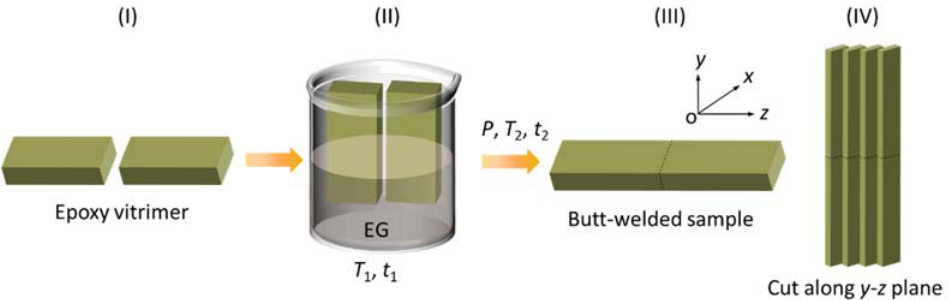
Figure 2. Schematic of the solvent-assisted welding process of epoxy vitrimer: ( I ) original epoxy vitrimer, ( II ) immersing into EG, ( III ) butt-welded vitrimer, and ( IV ) cut specimens for stretching. Table 1. Depolymerizing and welding conditions for epoxy vitrimer.